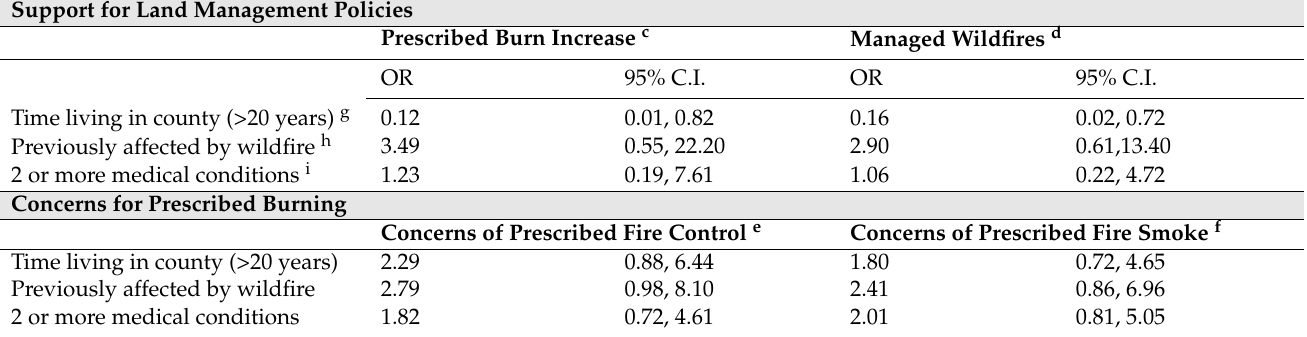
Table 5. Estimated odds ratios a for support and concerns regarding land management policies of increasing prescribed burns and managed wildfires, in a survey of a medically vulnerable adult population in Mariposa County, California, 2021 b